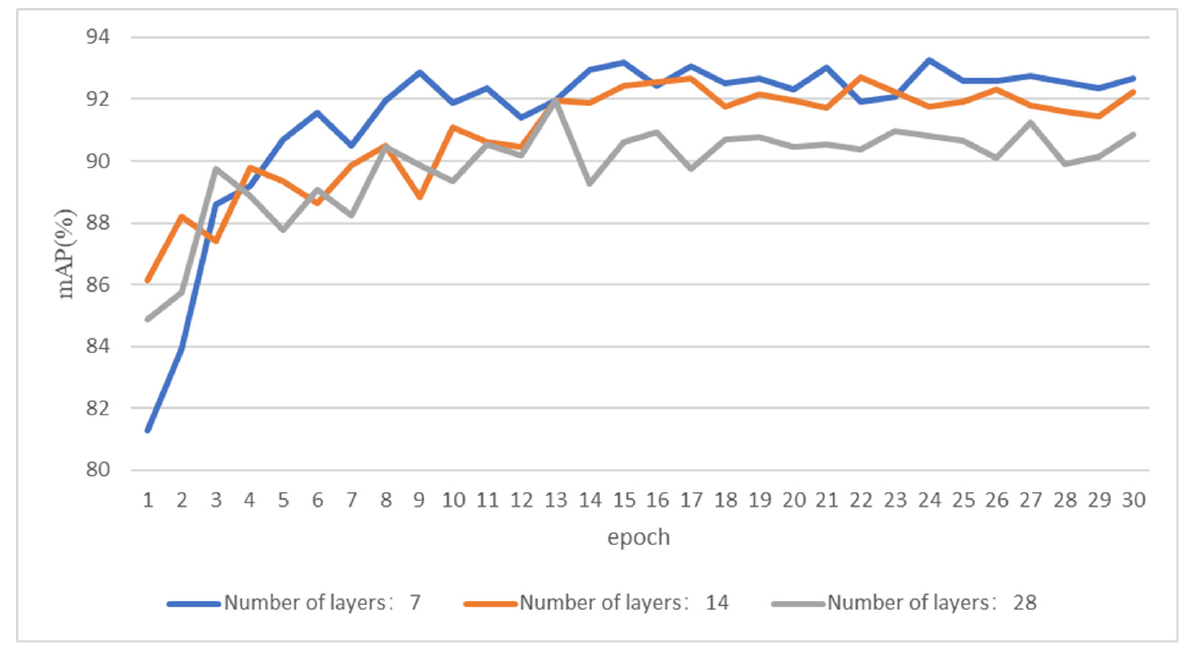
Figure 8. mAP values of the different layer structures.